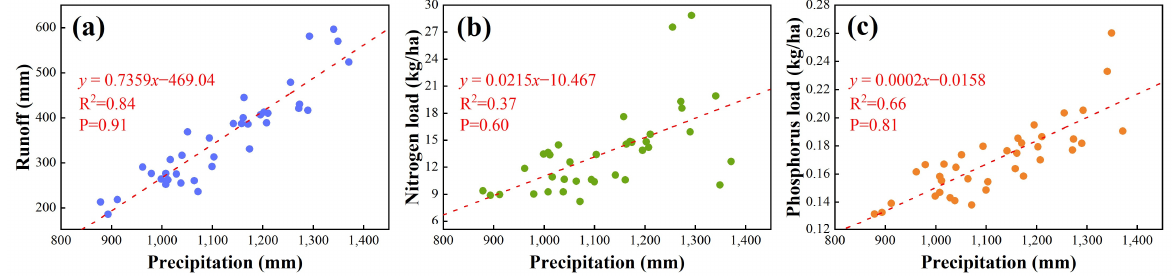
Figure 9. Correlation analysis between precipitation, runo ff ( a ), TN ( b ), and TP ( c ) loads in the TGRA.